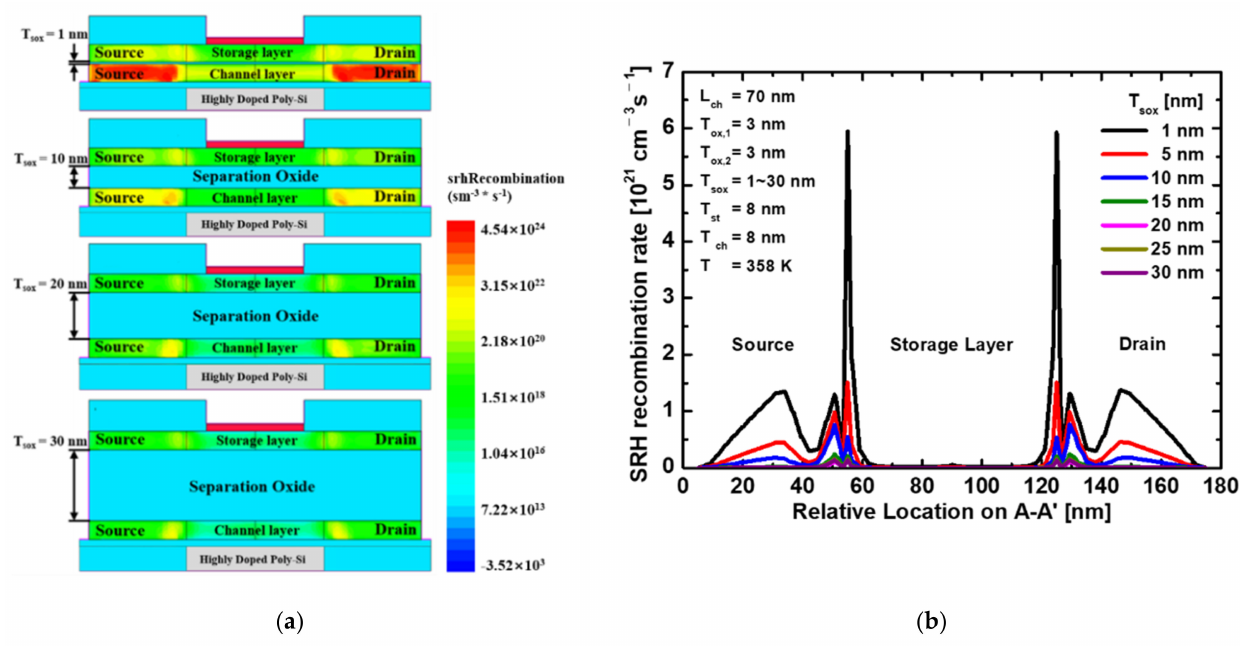
Figure 10. ( a ) Simulation profile of the 1T-DRAM with different T sox during hold “1” operation showing SRH recombination. ( b ) SRH recombination rate of storage layer with different T sox during the read operation. The energy band is extracted at 2 nm below the top gate